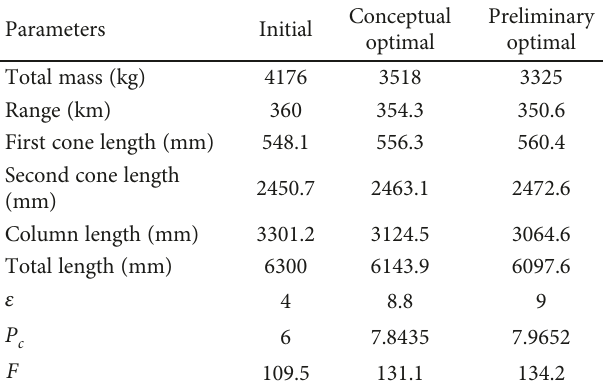
Table 10: All parameters of a solid propellant missile. Conceptual Parameters Initial